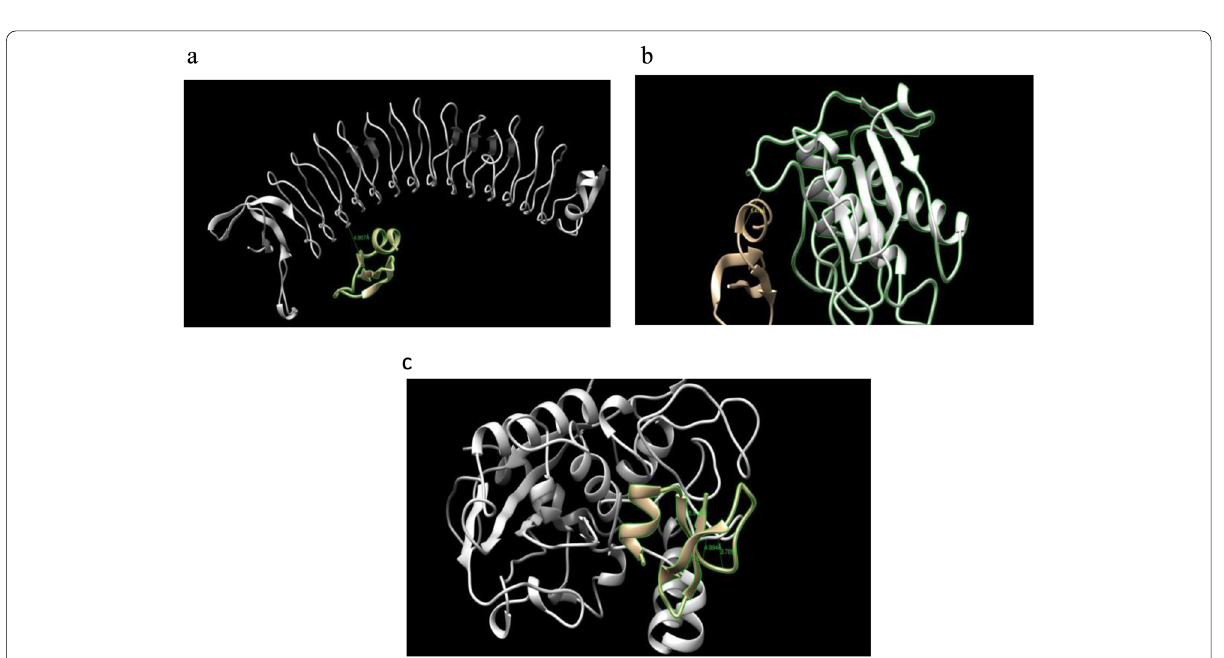
Fig. 9 Docking results of β-defensin 1 with a BspA, b karilysin, and c mirolysin of T. forsythia